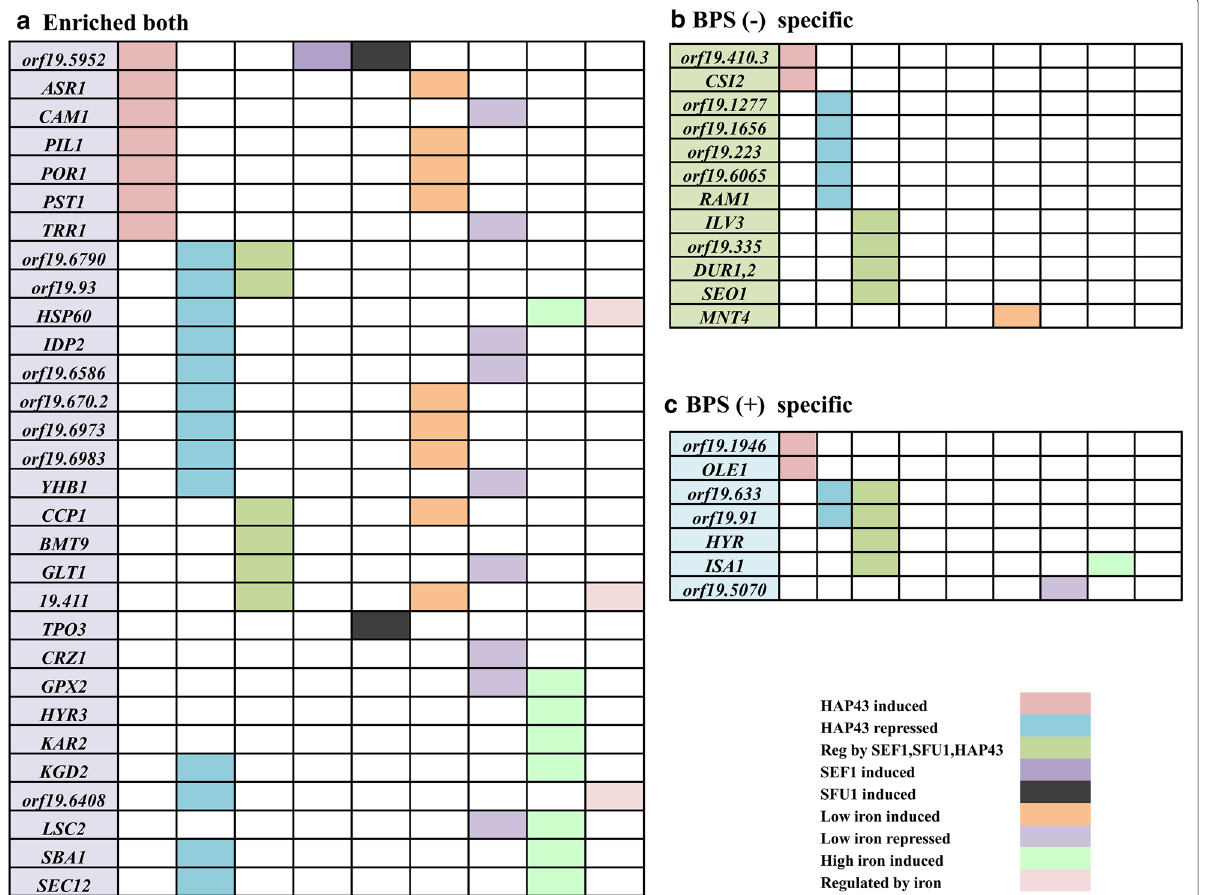
) specific ( b ), BPS ( ) specific ( c )] − +